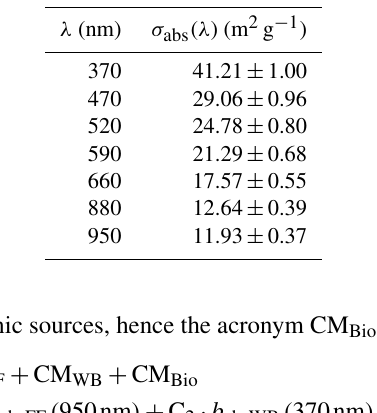
Table 2. Site-specific mass absorption coefficients (MACs) from the Vavihill measurement station. Values were obtained by linear regression analysis of measured absorption coefficients and elemen- tal carbon (EC) concentrations. The slope is equivalent to σ abs (λ) . Uncertainties are represented by standard errors ( N =